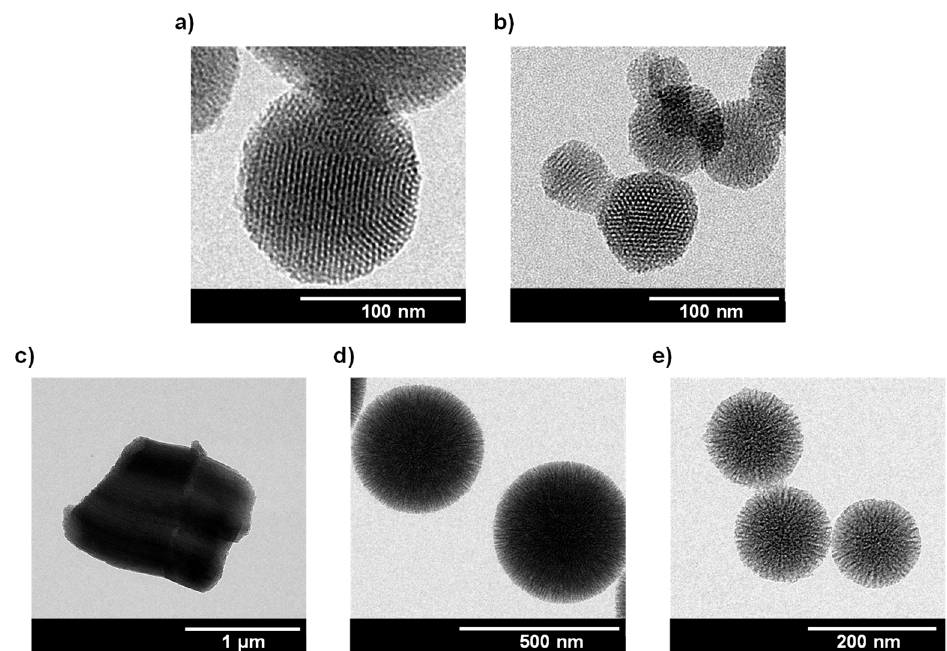
Figure 1. TEM images of ( a ) 1-MSN-Sn, ( b ) 2-MSN-Sn, ( c ) 2-SBA-Sn, ( d ) 2-FSPm-Sn, and ( e ) 2-FSPs-Sn.